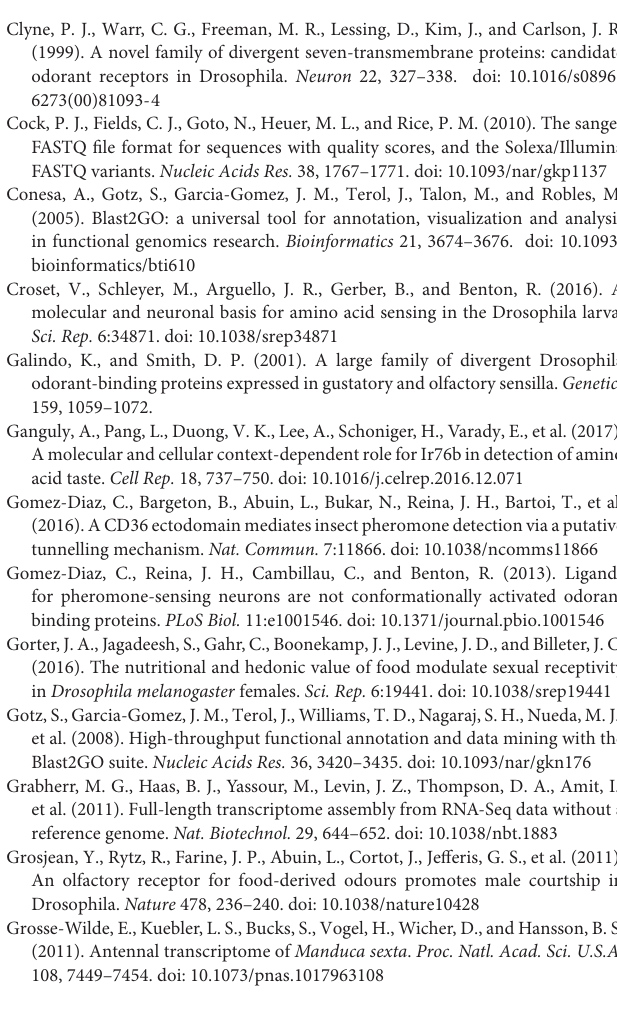
TABLE S5 | Overview of the sequencing and assembly